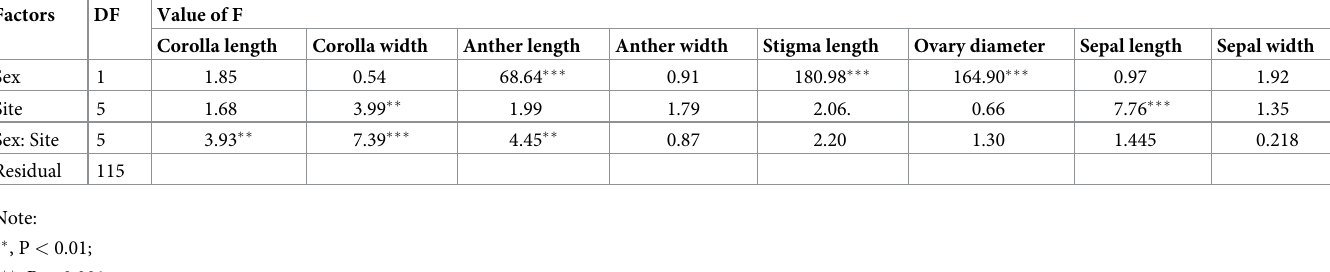
Table 3. Two-way ANOVA results for floral dimorphism of O . delavayi